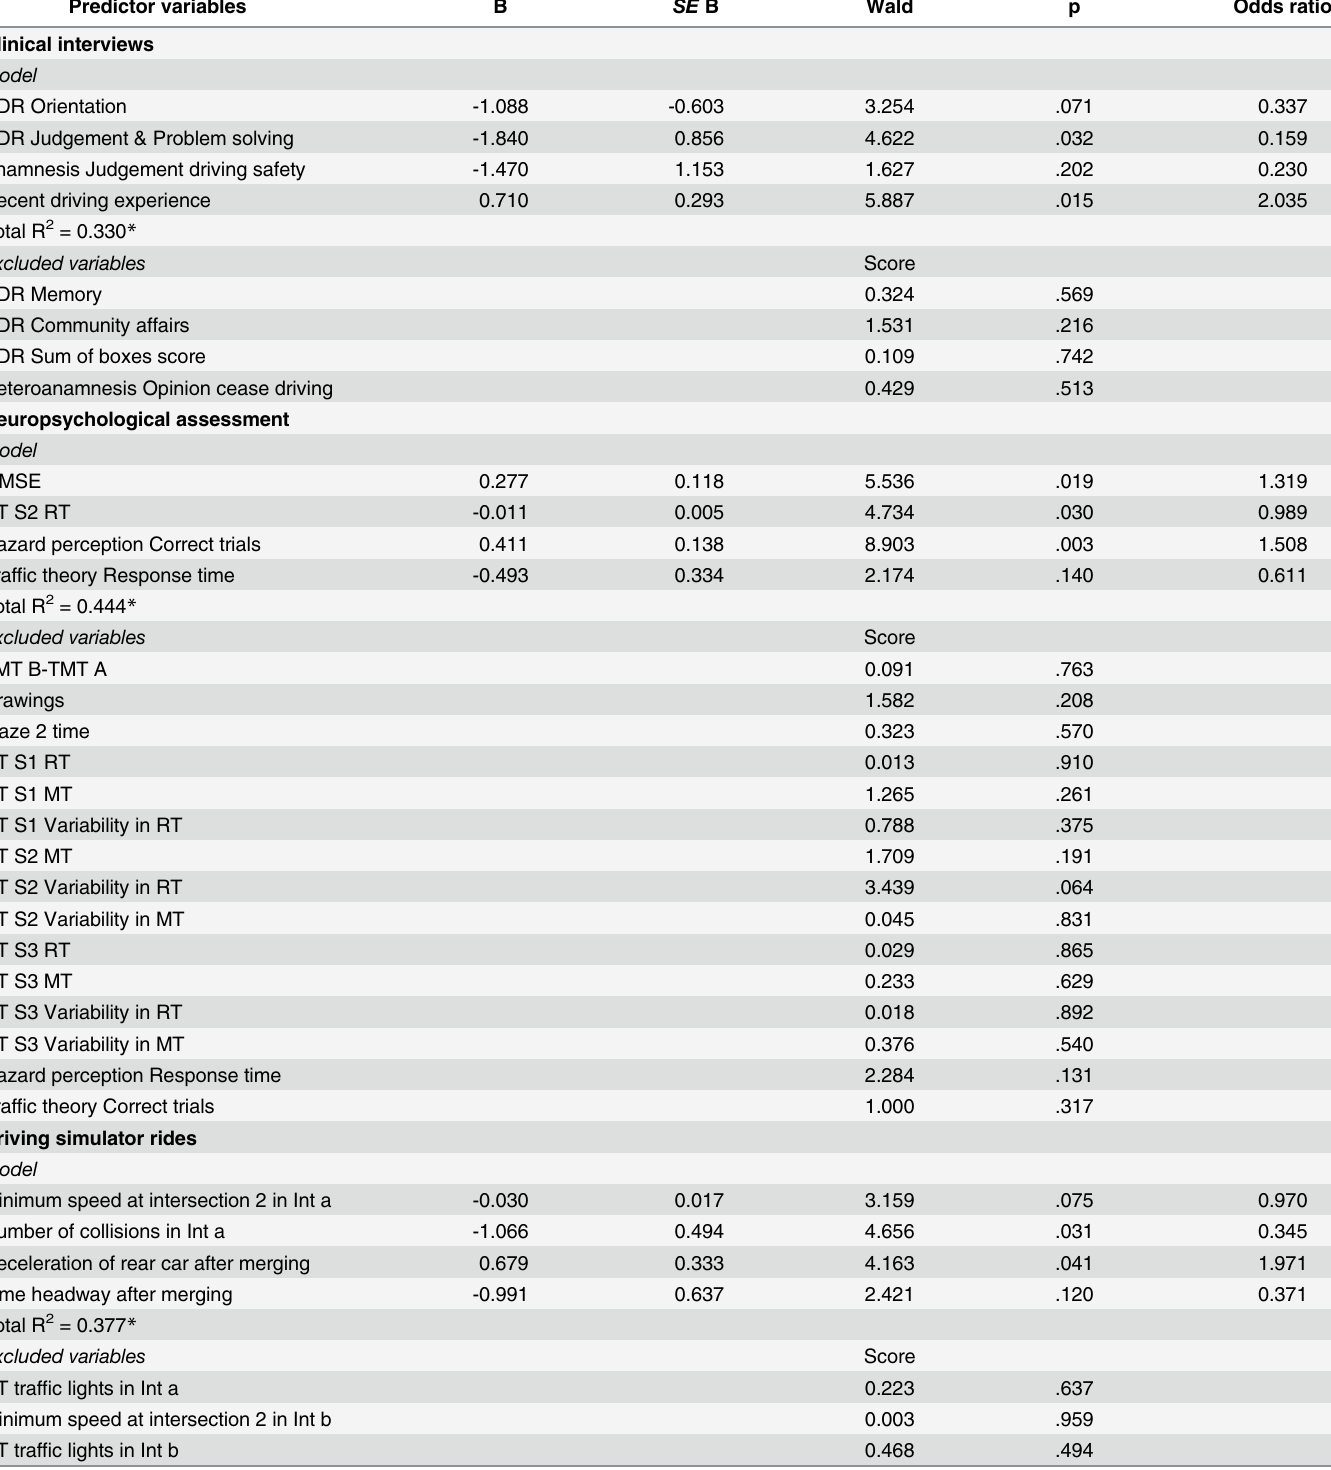
Table 4. Summary of forward logistic regression analyses of predictor variables from the clinical interviews, neuropsychological assessment and driving simulator rides on fitness to drive for patients with Alzheimer ’ s